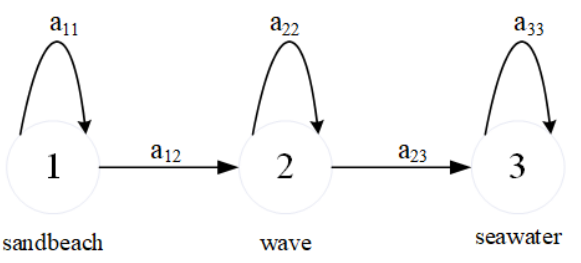
Figure 5. The HMM with three states for a “Beach” image.